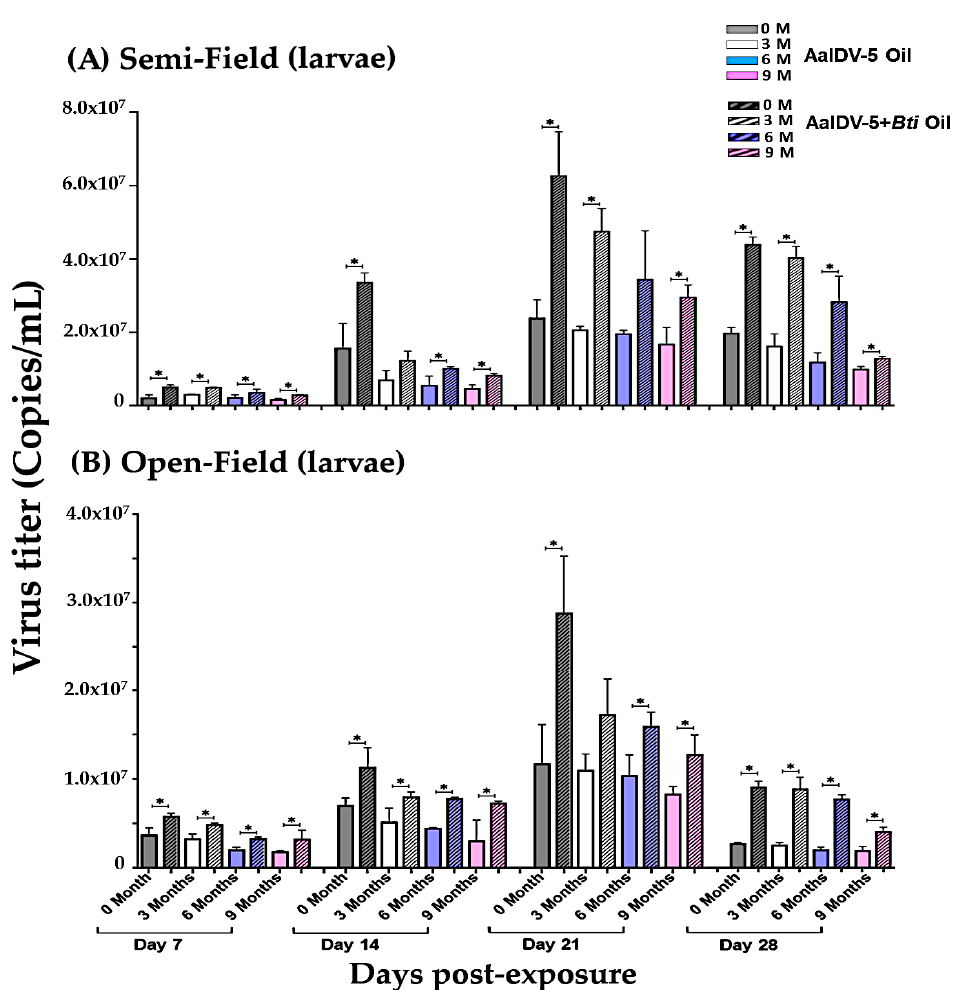
Figure 5. AalDV-5 quantification in larvae. First instar Ae. albopictus larvae were exposed with AalDV-5 oil and AalDV-5+ Bti oil (1 × 10 8 copies/mL) in 4 L of water, and virus titer in fourth instar single larvae was determined on a weekly basis in semi- and open-field conditions. ( A ) AalDV-5 viral titer in semi-field conditions. Virus titer was determined on days 7, 14, 21, and 28. ( B ) AalDV-5 viral titer in open-field conditions. AalDV-5 titer was determined on days 7, 14, 21, and 28, on a weekly basis. The error bars indicate SDs from three independent (biological) replicates ( n = 25 per replicate). The significance of the difference among the oil samples in different weeks was calculated by t ‐ test using IBM SPSS ( A , B ), and the significant difference is indicated by * ( p < 0.05).